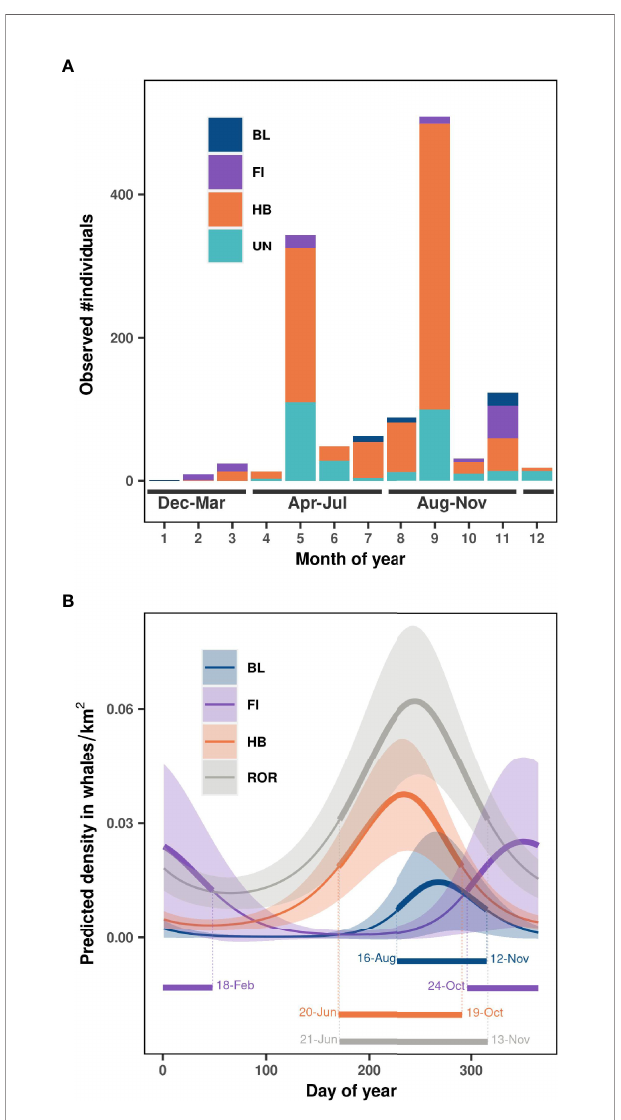
FIGURE 3 | Temporal distribution in (A) observed number of individual whales per month, and (B) predicted whale density estimated over the study region per day of year. BL, blue whales; FI, fi n whales; HB, humpback whales; UN, Unidenti fi ed rorquals; ROR, all rorquals species pooled together. Season delimitations are represented at the bottom of panel (A) . Solid lines represent the marginal effect of day of year on whale density (with year fi xed to 2020) and shaded areas represent approximate 95% con fi dence intervals in panel (B) . Half-density ranges representing the peak of occurrence for each species are shown at the bottom of panel (B)